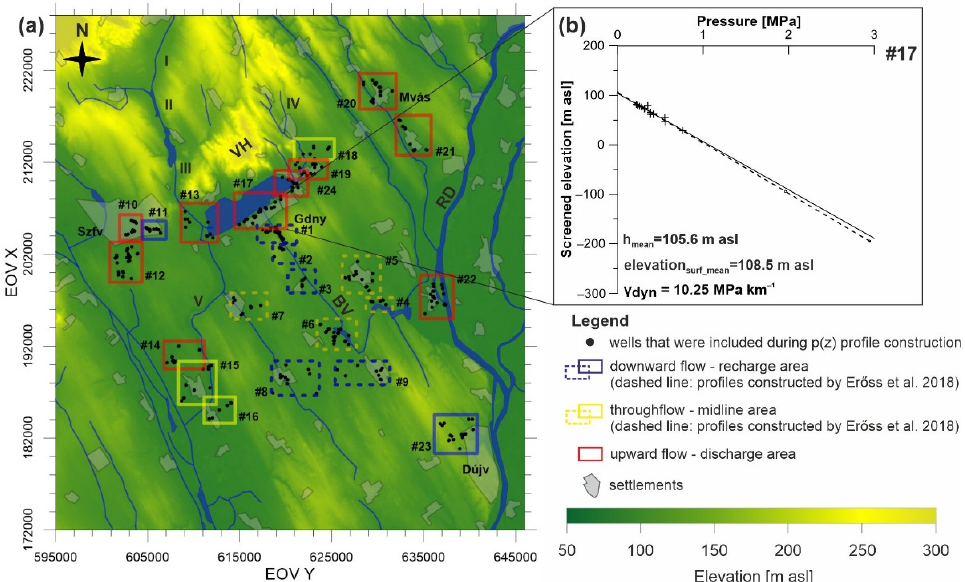
Figure 3. ( a ) Groundwater regime types according to the constructed pressure-elevation profiles. P(z) profile areas derived from [29] are distinguished by using dashed lines. Main settlements: